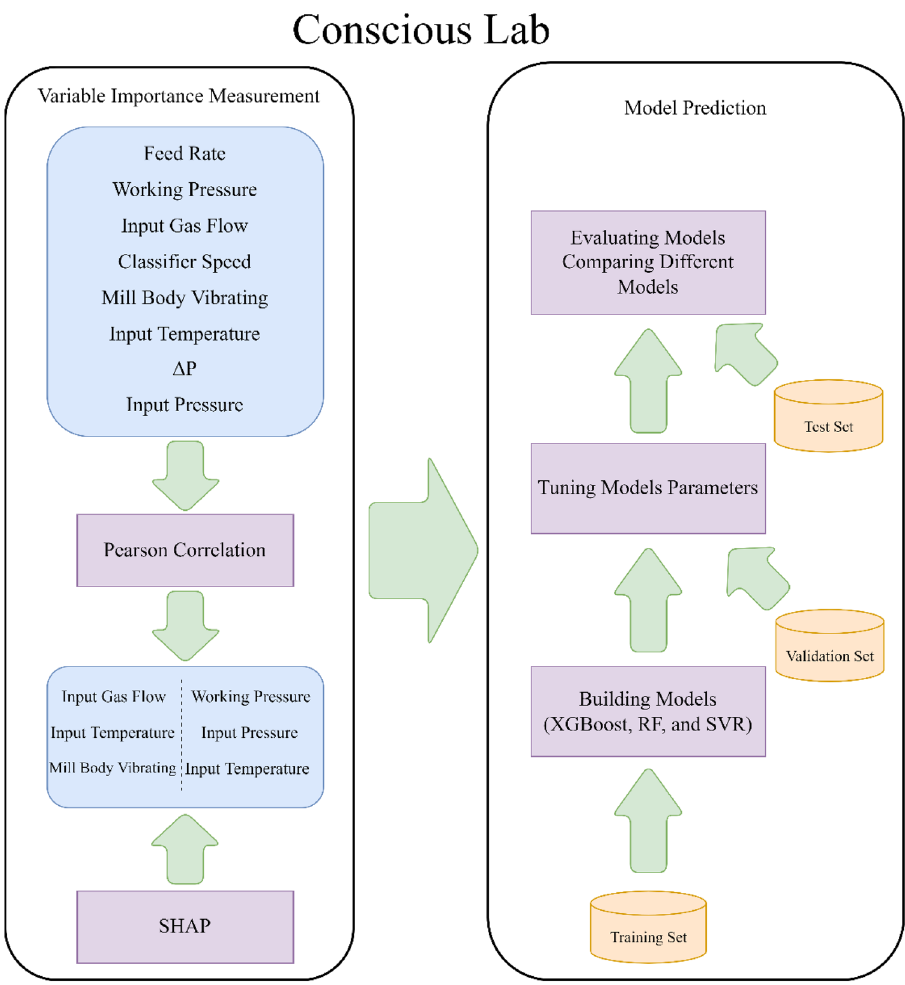
Figure 2. Constructing a conscious lab for a vertical roller